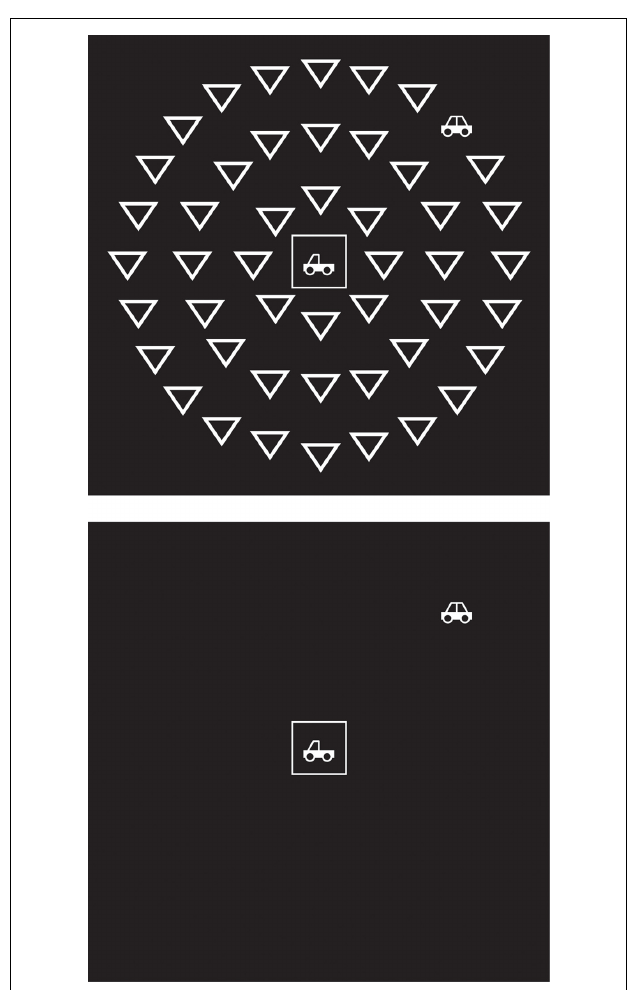
FIGURE 1 | Example of trial in the selective subtest (upper panel) and in the divided subtest (lower